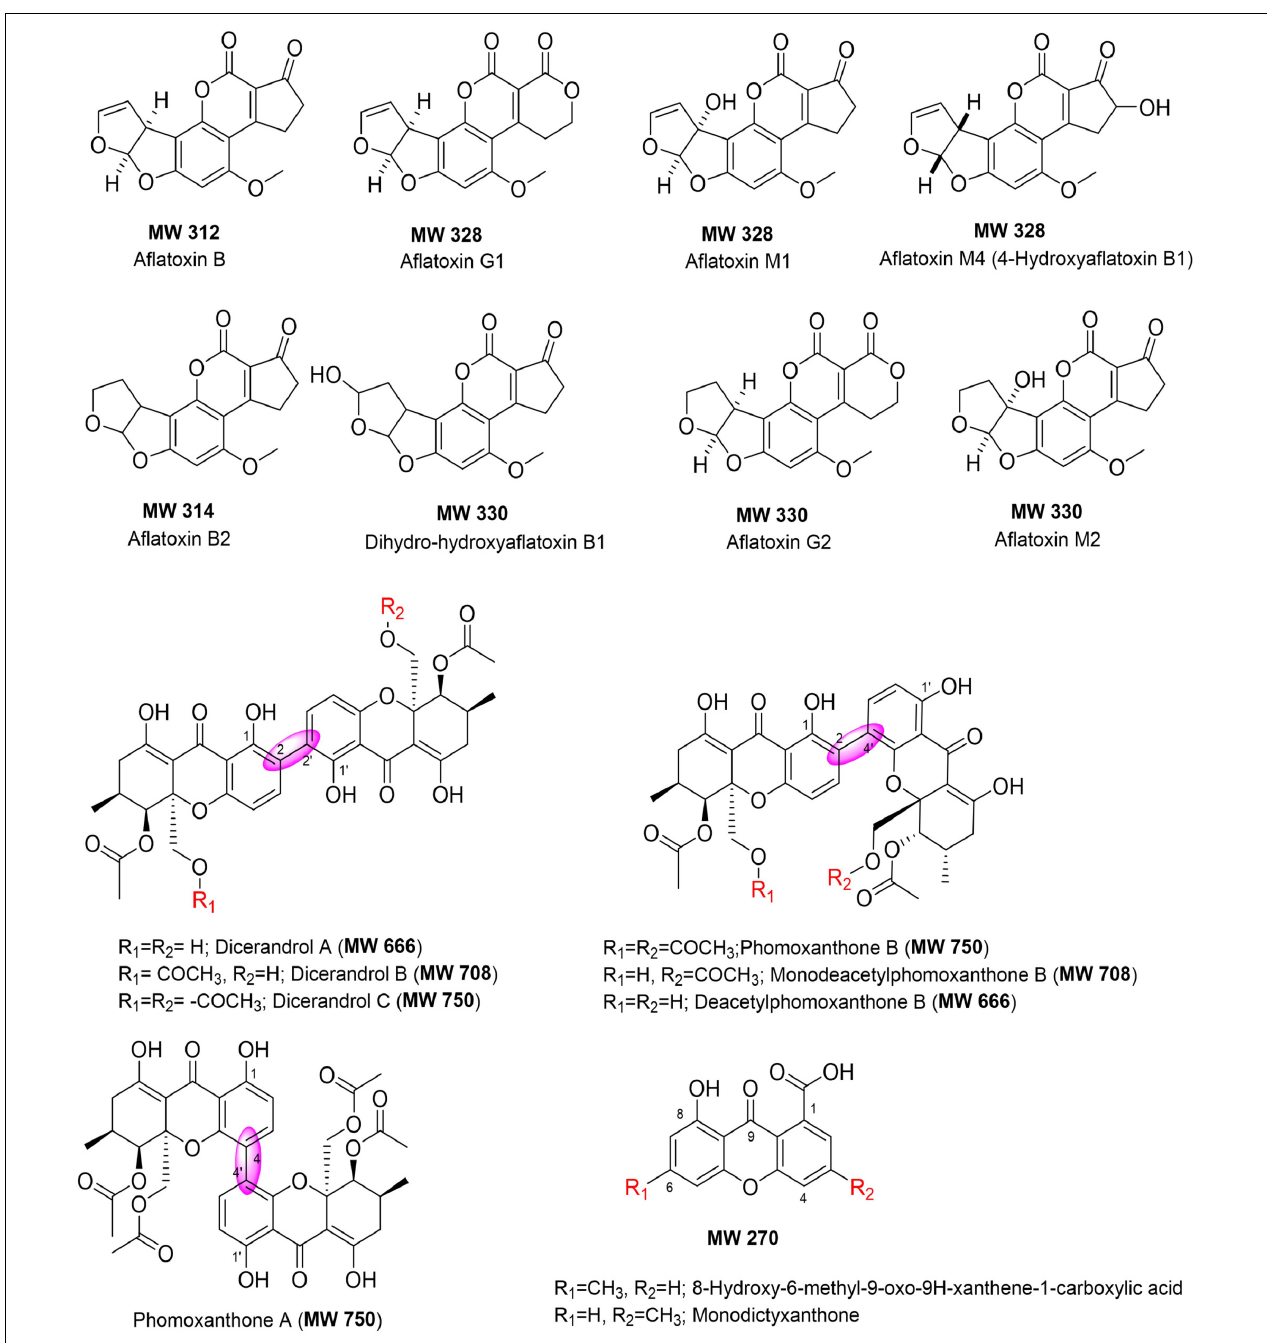
FIGURE 6 | Chemical structures of compounds identified in the extracts of selected endophytic fungi (using HPLC-UV/vis, MS and TLC analyses, and AntiBase search).